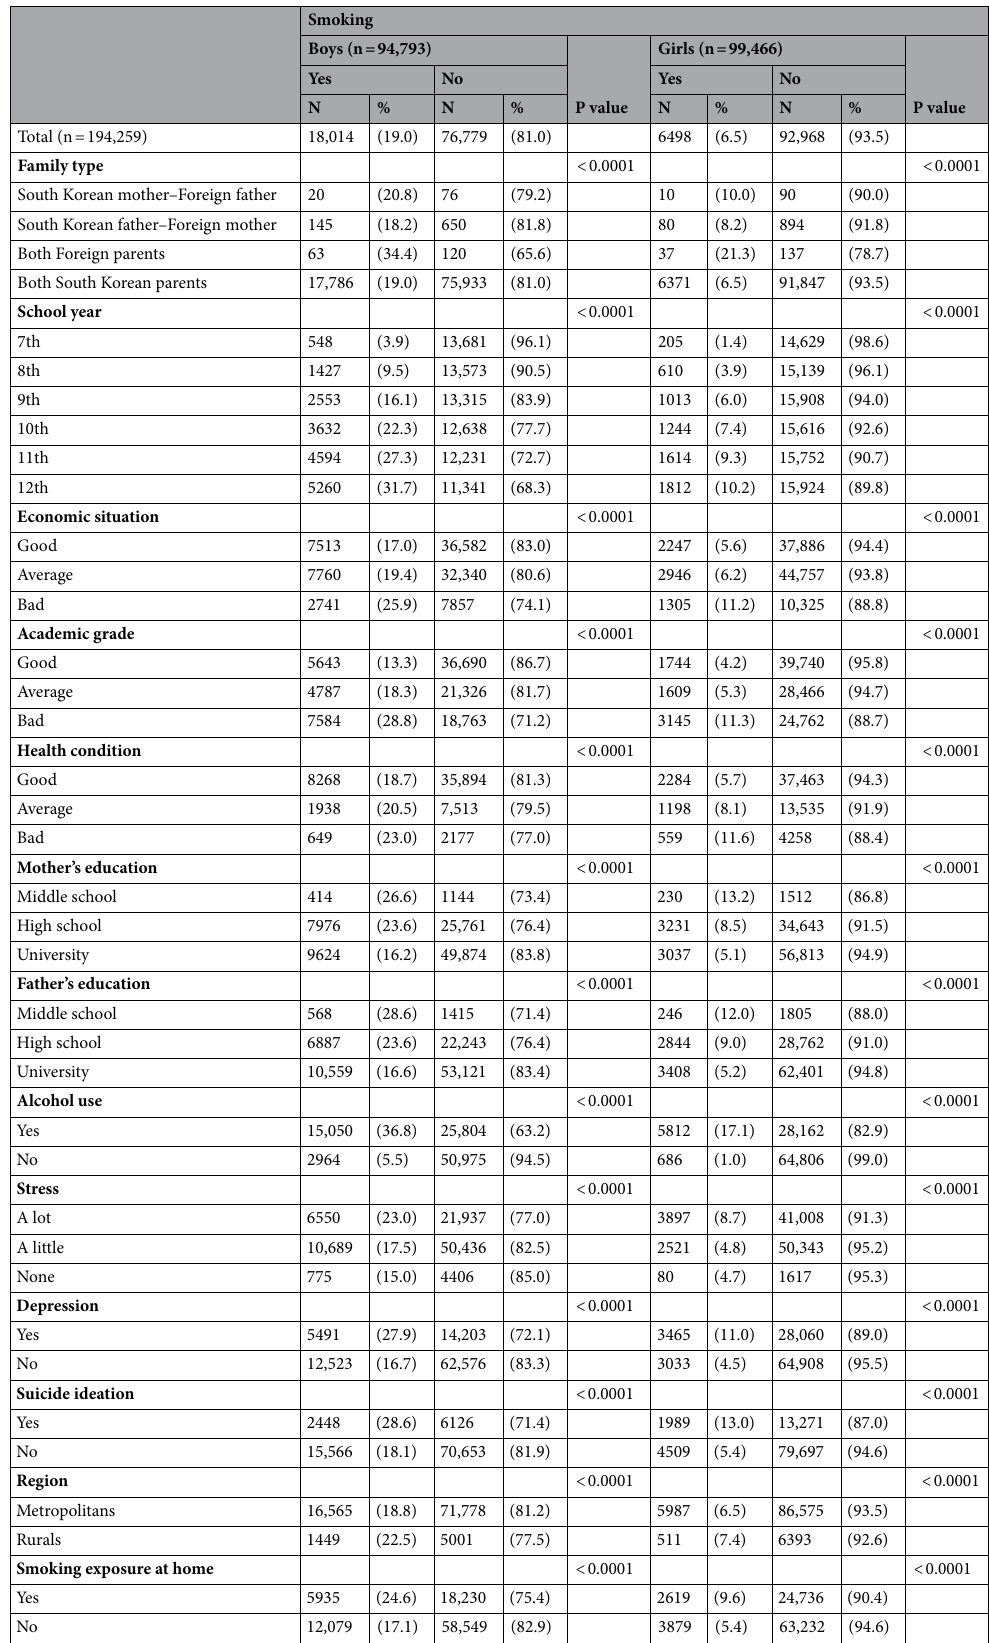
Table 1. General characteristics of study